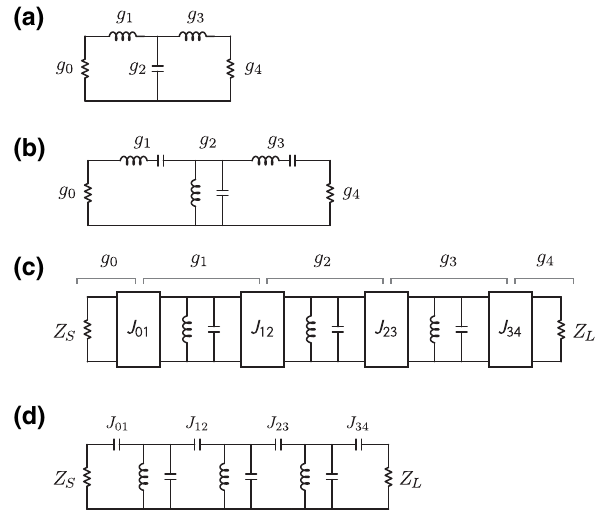
FIG. 10. Example of three-pole band-pass network construc- tion. (a) Low-pass prototype, (b) band-pass transformation, (c) added admittance inverters, and (d) inverters